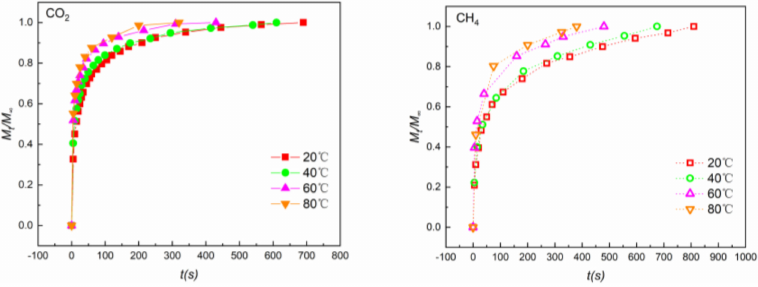
Figure 5. Adsorption rates of CO 2 and CH 4 at 1 MPa.